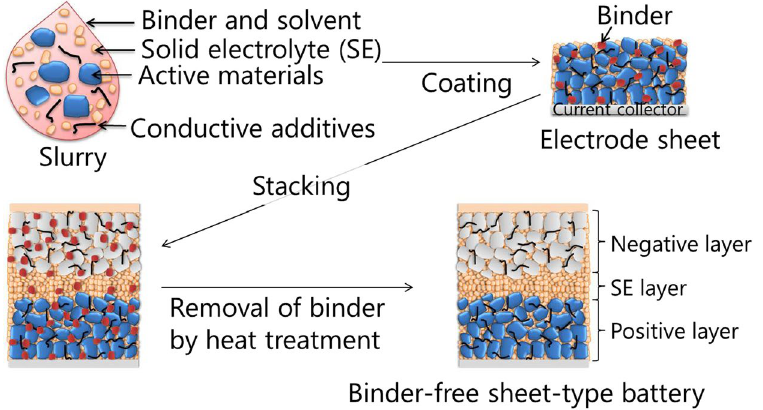
Figure 1. Strategy for the fabrication of binder-free sheet-type ASSLBs. Schematic diagram showing the fabrication process for binder-free sheet-type